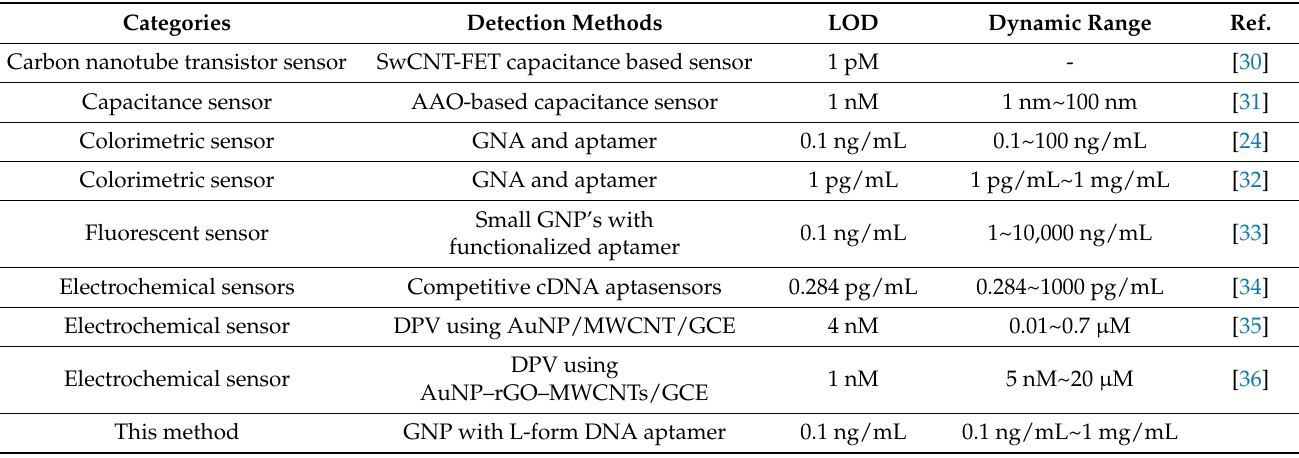
Figure 7. The A 640 /A 520 ratio versus the BPA concentration. The peak absorbance ratio (A 640 /A 520 ) is linear with respect to the logarithm of the BPA concentration (0.1~10,000 ng/mL) with the linear function y = 0.0436x + 0.1815 (R 2 = 0.9935). Table 1. Various BPA biosensors with aptamer as probe.